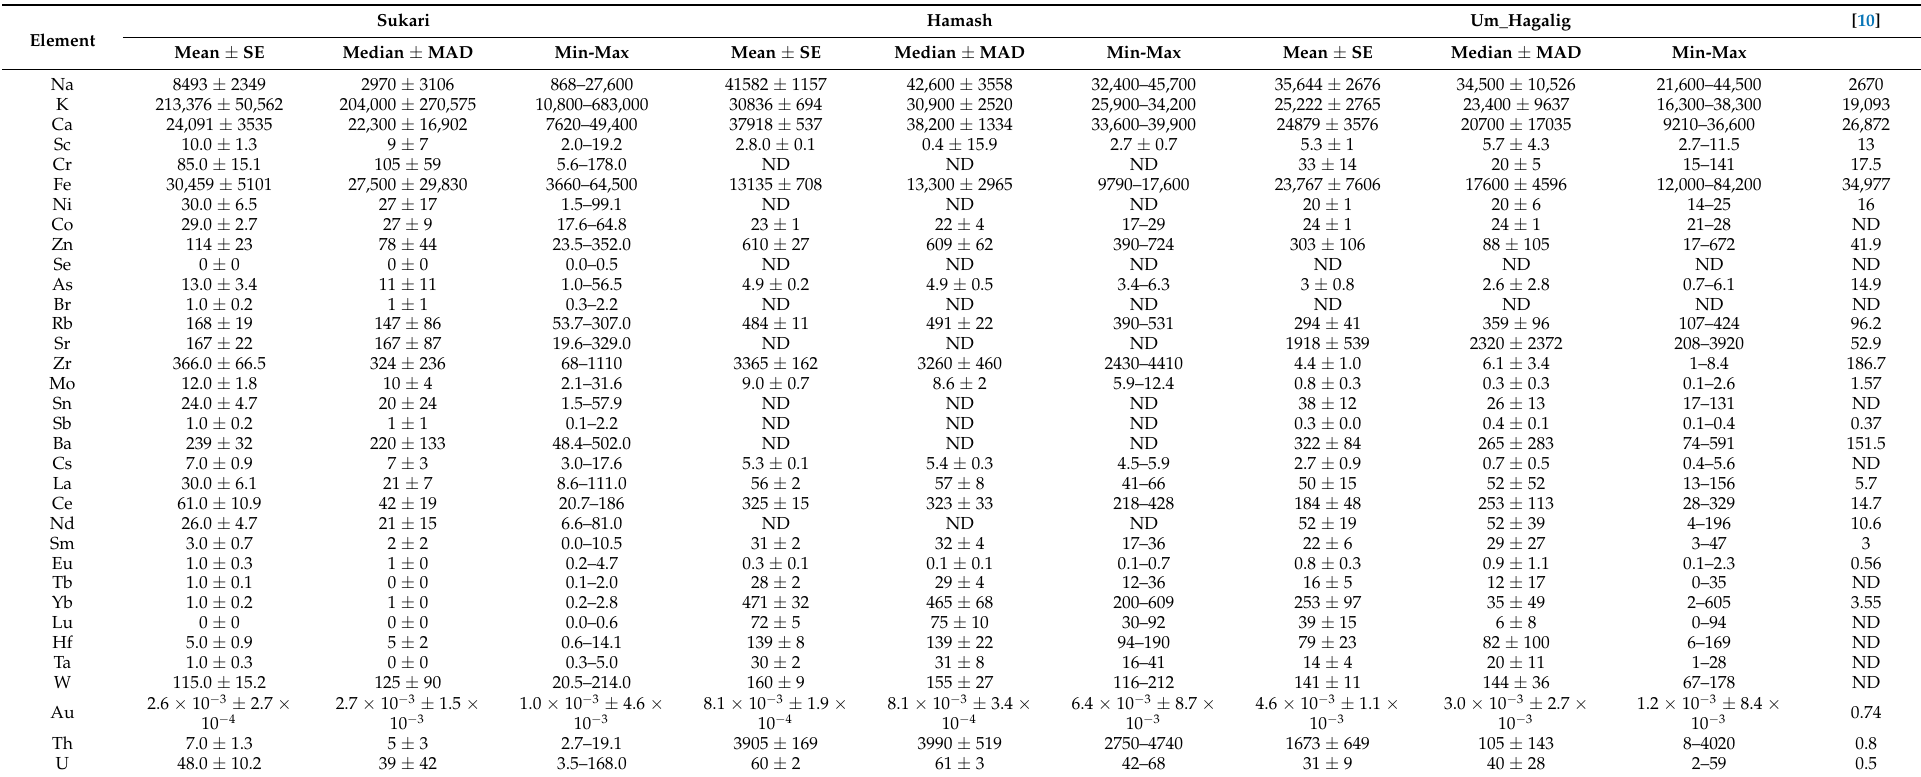
Table 1. Mean, median, and median absolute deviation of the elemental composition of the studied areas. All the mass fractions are expressed in mg/kg ( n =